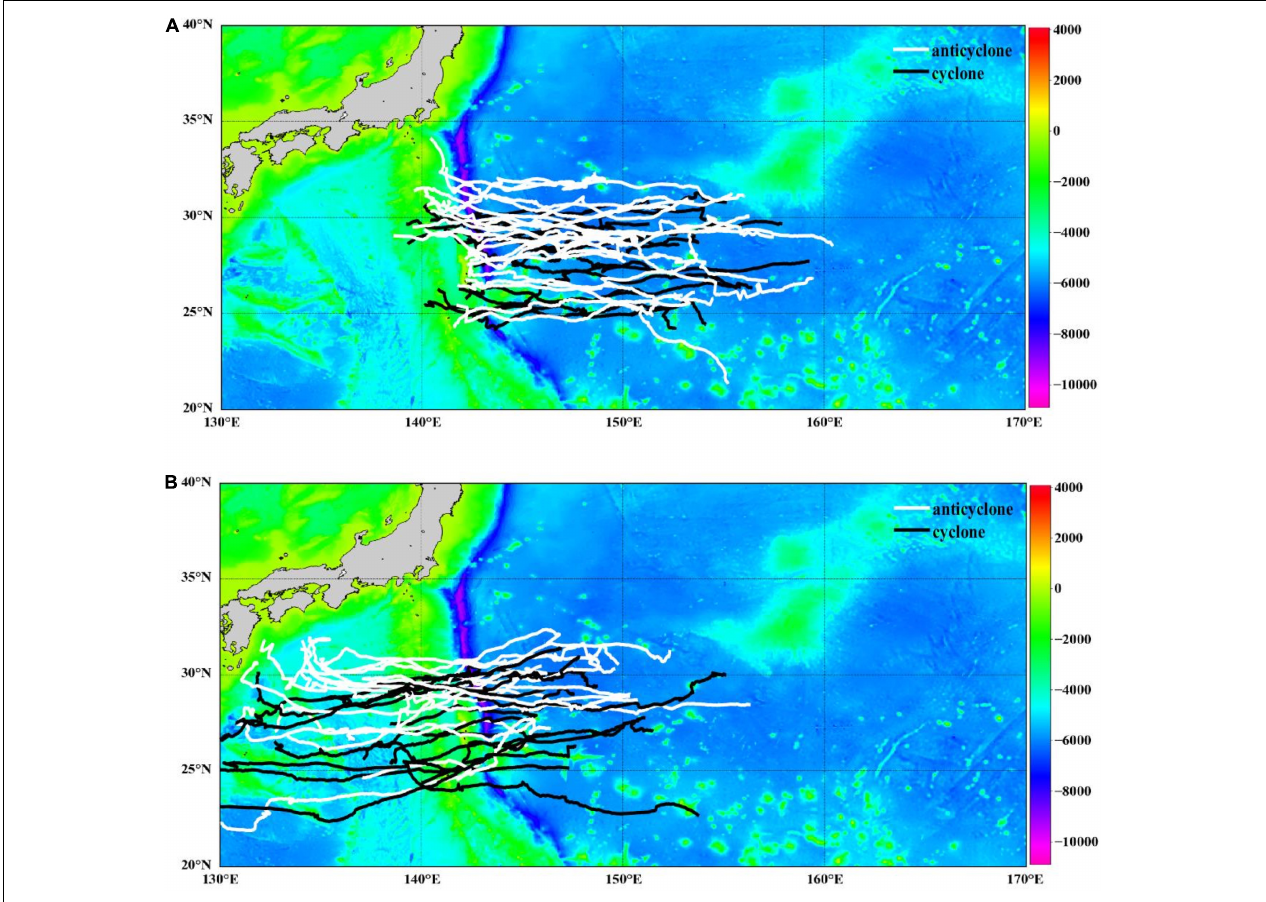
FIGURE 2 | Mesoscale eddy trajectories. (A) Mesoscale eddy trajectories that completely pass through the ridge, with cyclonic in black and anticyclonic in white. (B) Mesoscale eddy trajectories that partially travel across the ridge, with cyclonic in black and anticyclonic in white.